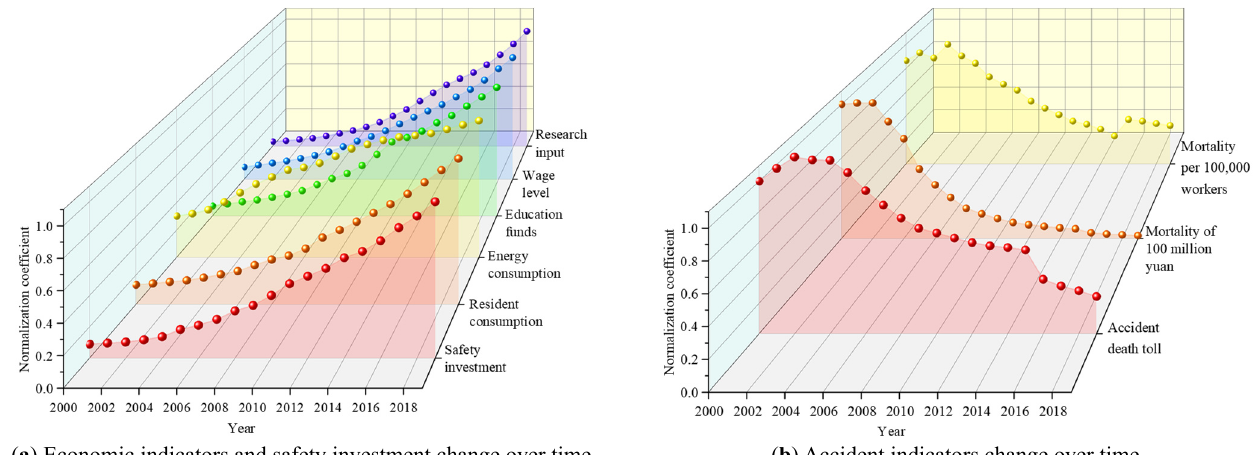
Figure 7. Economic indicators and accident indicators change with time.